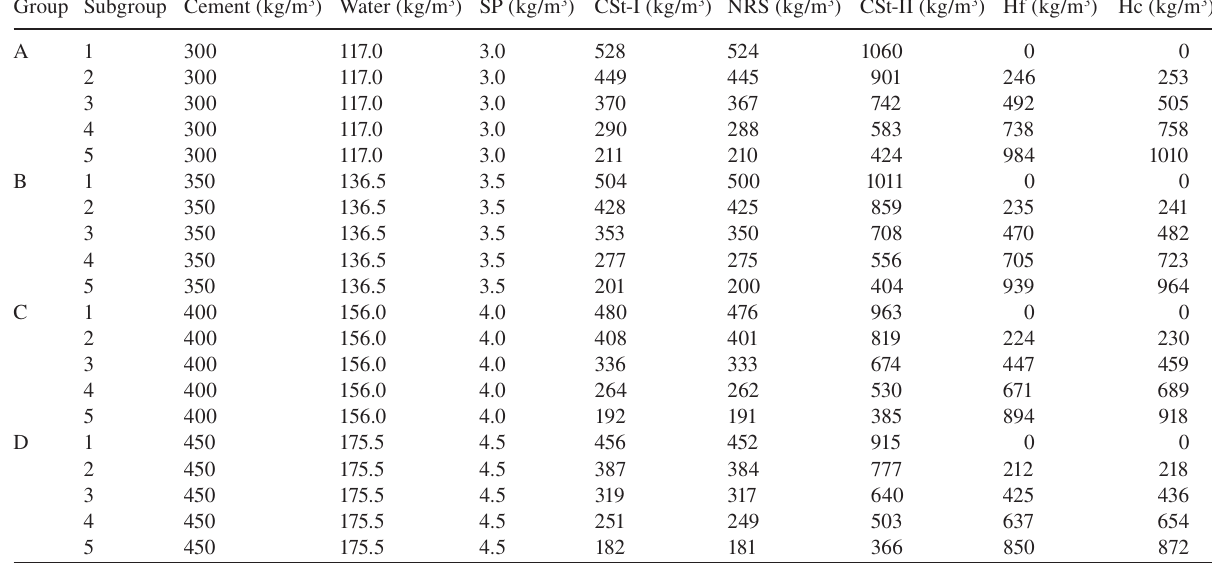
Table 6 Mixture proportions.